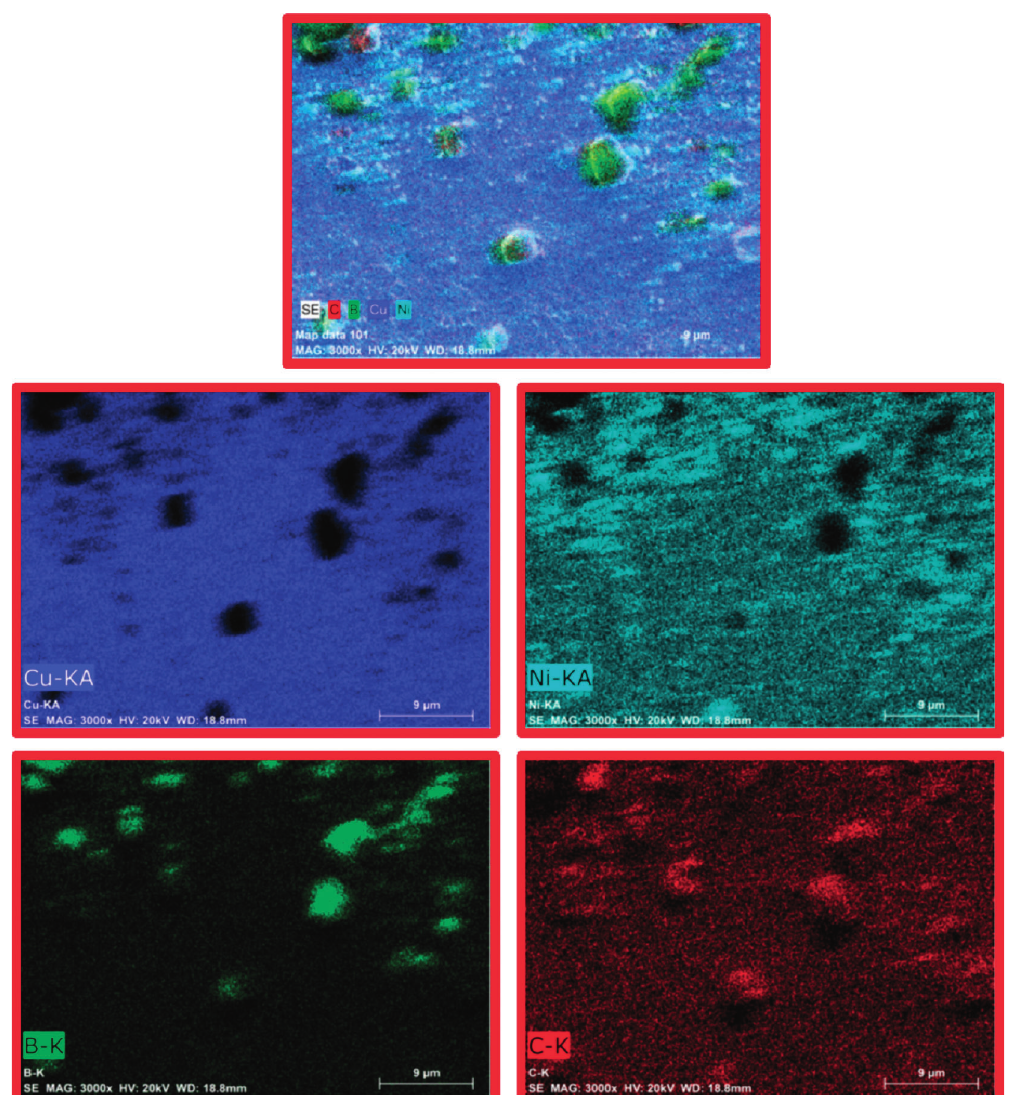
Figure 9: Electron image mapping of FSP sample indicating reinforcement of B